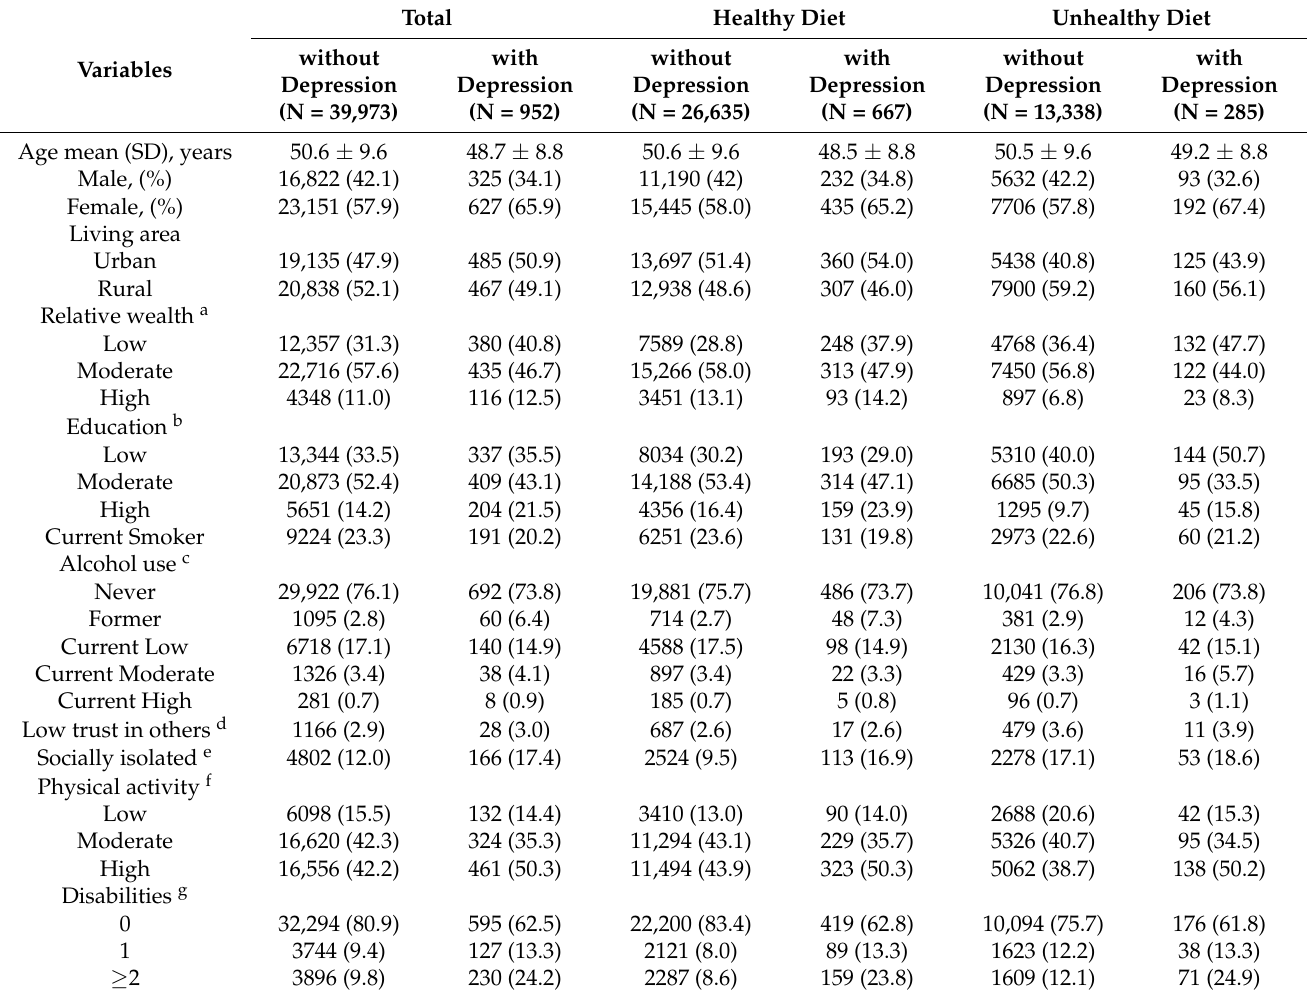
Table 1. Baseline information of participants grouped by depression and